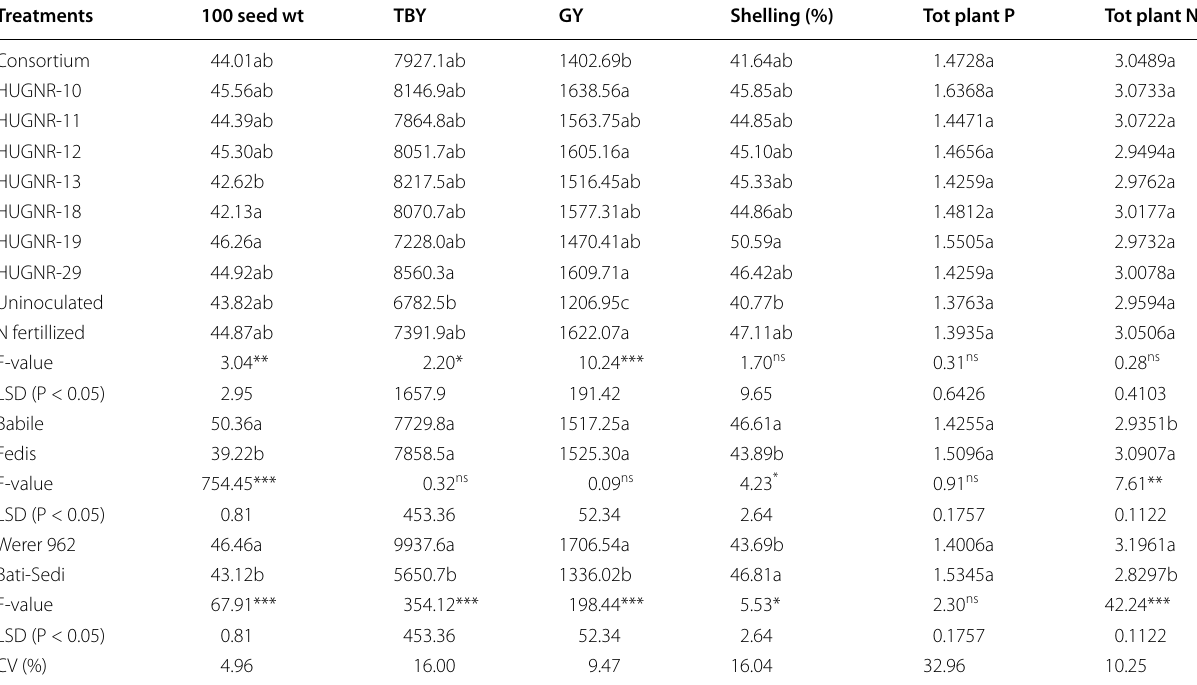
Means in the same column followed by the same letter are not significantly different at the 5% probability level by Tukey’s test ns non-significant, TBY total biomass yield (kg ha − 1 ); GY grain yield (kg ha − 1 ) * Significant at 0.05; ** significant at 0.01; *** significant at